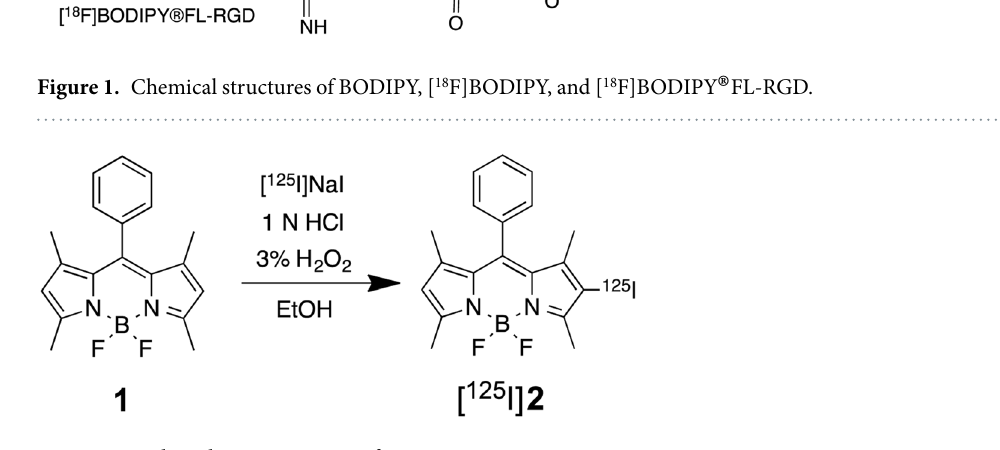
Figure 2. Radioiodination reaction of